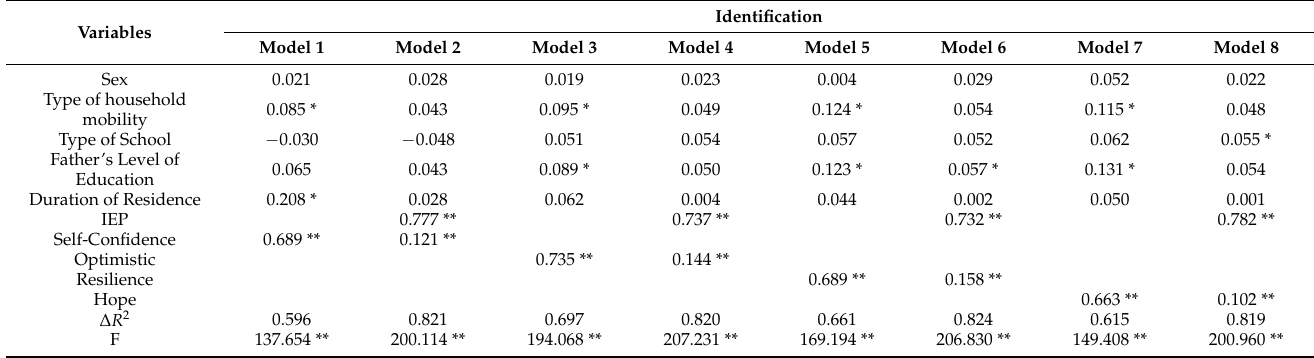
Table 3. Moderating effect of PC on the relationship between IEP and